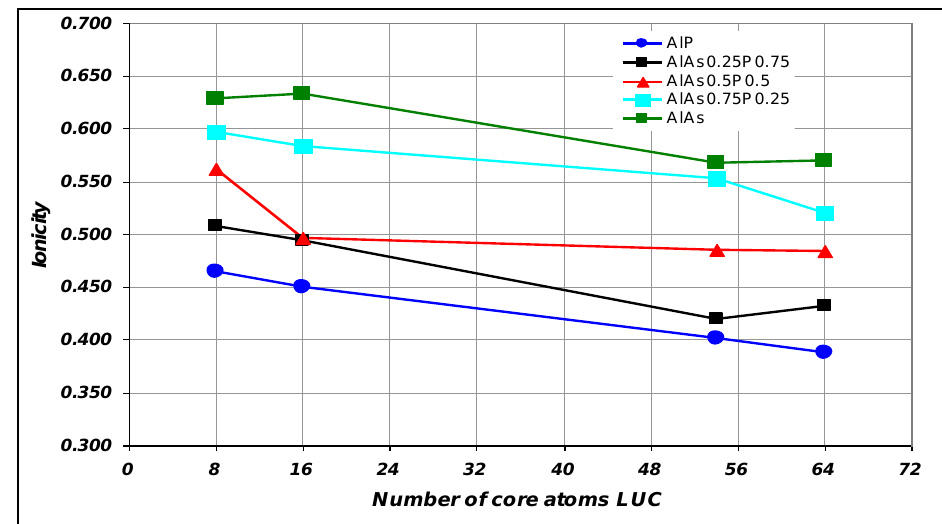
Fig.7: Ionicity of Al As